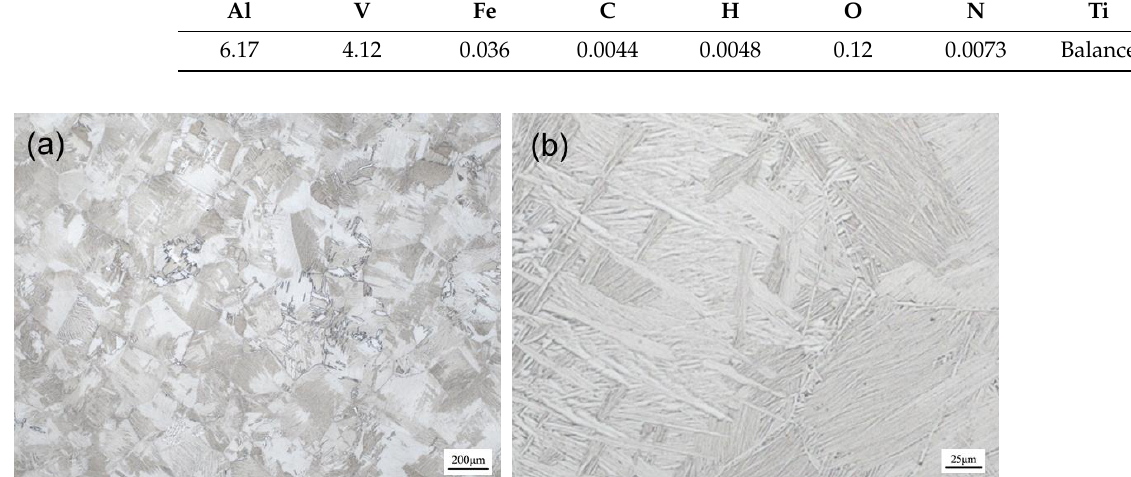
Figure 2. Microstructure of extruded Ti-6Al-4V alloy profile: ( a ) 50 x ; ( b ) 500 x .